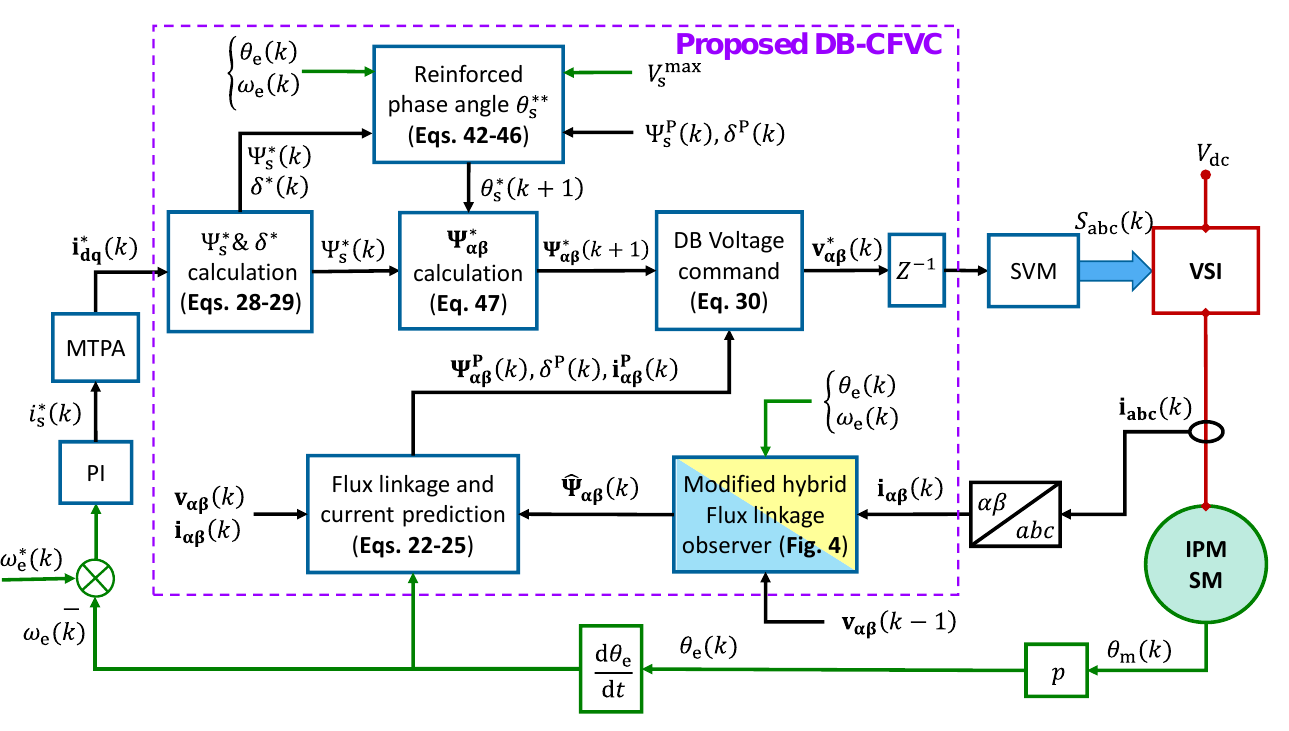
Figure 3. Complete block diagram of the proposed DB-CFVC.